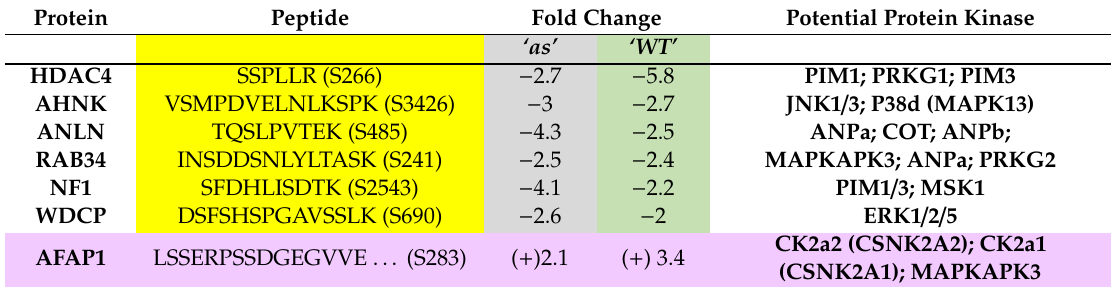
Table 2. Peptides decreasing > 2-fold in both experimental (CDK12 as = ‘as’) and control (CDK12 WT = ‘WT’) experiments. Phosphorylated residue indicated in the ‘Peptide’ column.